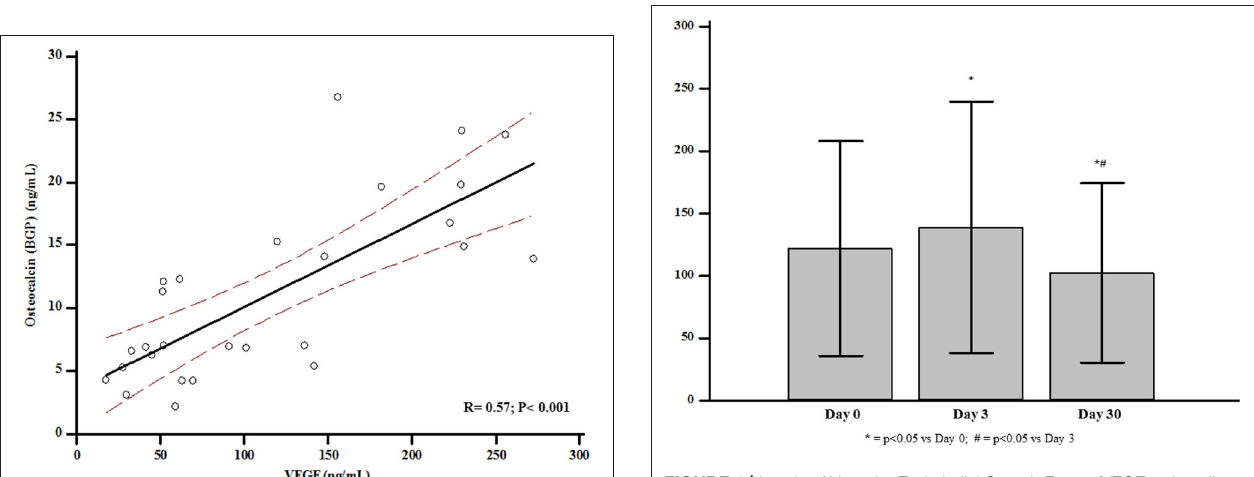
values ( r = 0.29, p = 0.028) ( Figure 5 ). Change of VEGF at day- 3 was also associated with CTX levels ( r = 0.77, p =